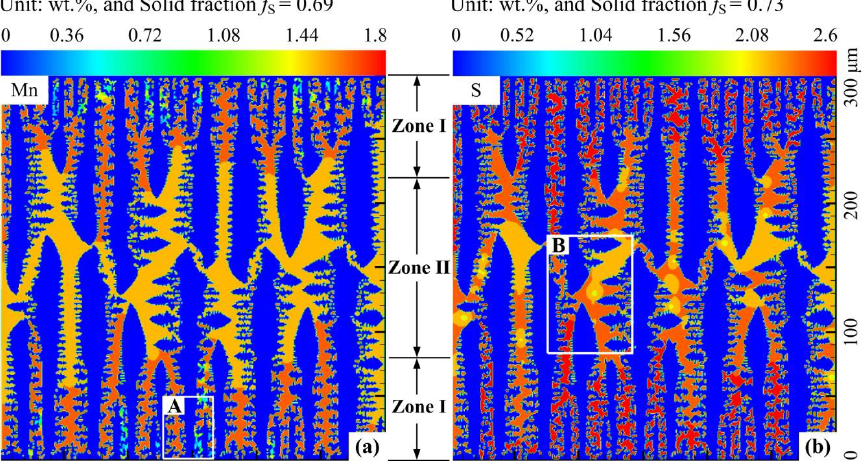
Figure 5. Solidification morphology expressed by solutal concentration of elements ( a ) Mn and ( b ) S.